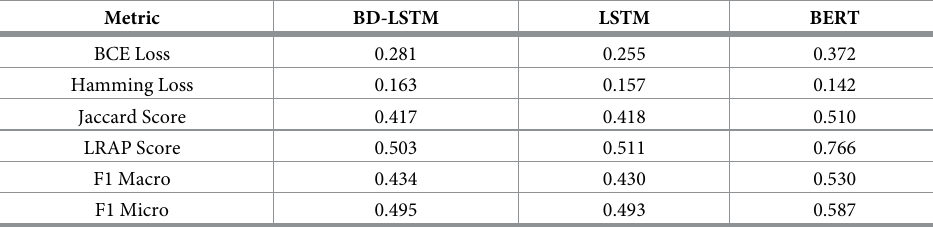
Table 2. Training performance for BD-LSTM, LSTM and BERT model using Senwave COVID-19 training dataset. Note that except for the BCE and Hamming loss, higher scores shows better